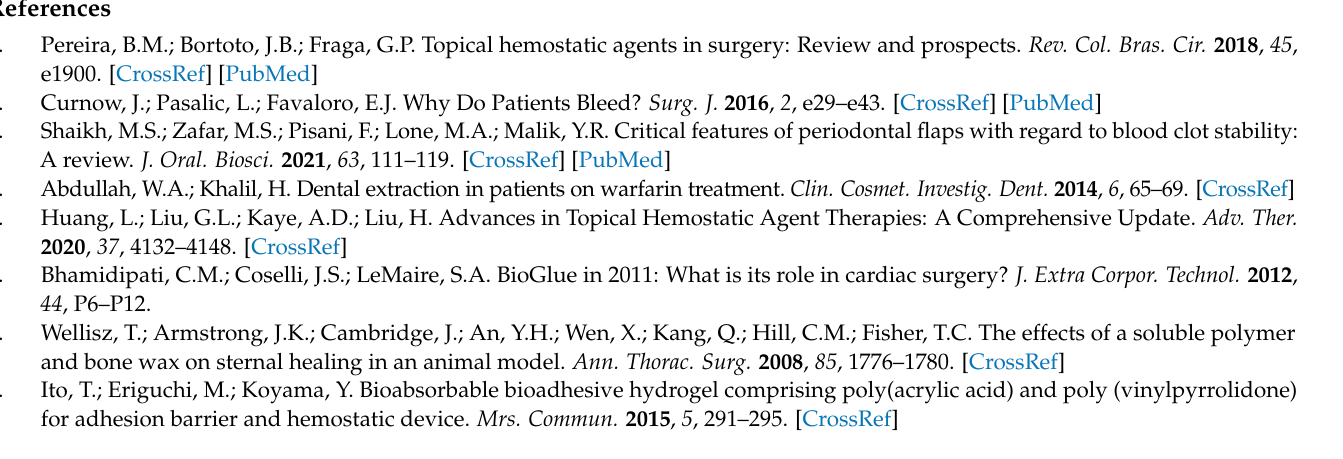
polymers; Figure S2: The morphology of Gel-Phe hydrogels synthesized with different G/P ratios; Figure S3: The SEM morphology of GelMA hydrogels without the addition of Gel-Phe; Video S1: Hemostatic test using the in vitro porcine skin bleeding model; Video S2: Hemostatic test using the in vitro dental bleeding